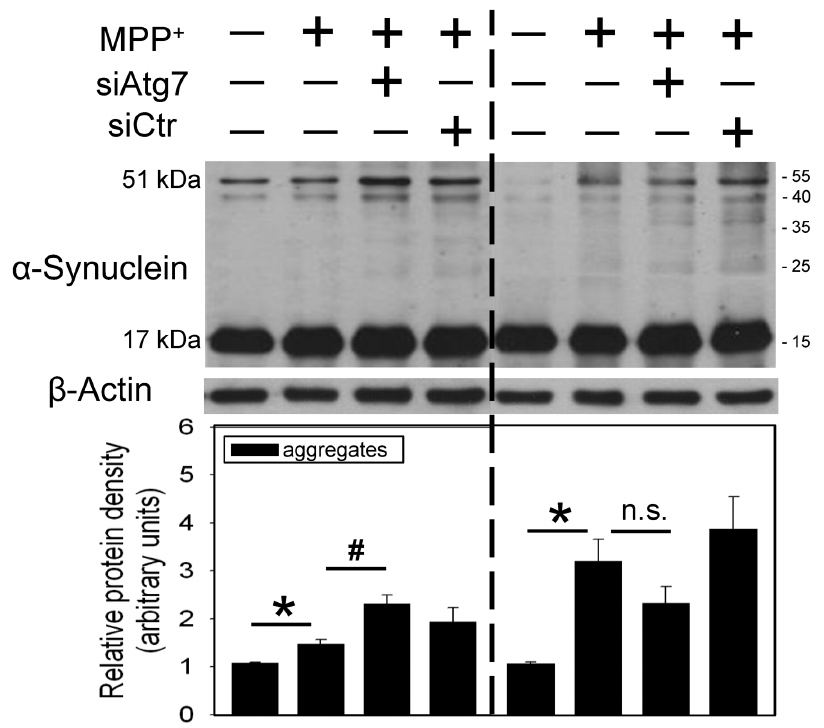
Figure 6. Differential effects of in vivo Atg7siRNA transfection on MPP + -induced a -synuclein aggregation in the nigrostriatal dopaminergic system of rat brain. Intranigral infusion of Atg7siRNA was performed 4 days prior to intranigral infusion of MPP + (3 m g/ m l) in the anesthetized rats. Rats were sacrificed 30 h after intranigral infusion of MPP + . The levels of a -synuclein aggregation in the substantia nigra (SN) were measured using Western blot assay. Each lane contained 25 m g protein for the experiments. Graphs show statistical results of a -synuclein (51 kd) from relative optical density of bands on the blots estimated by Image J software. Values are the mean 6 S.E.M. (n=4). *P , 0.05 in the MPP + -infused SN compared with the intact SN, # P , 0.05 in Atg7siRNA transfected and MPP + -infused SN compared with MPP + -infused SN, n.s. for not significant by Kruskal-Wallis test and followed by Mann-Whitney U test as post-hoc method.